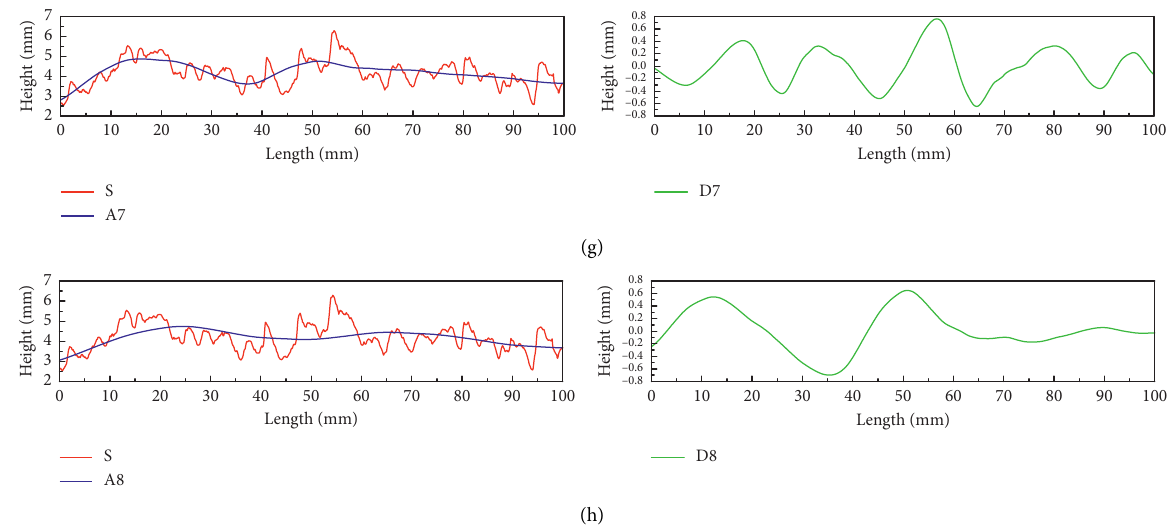
Figure 2: The approximate profiles Ai and detailed profiles Di under different decomposition levels: (a) Level 1. (b) Level 2. (c) Level 3. (d)